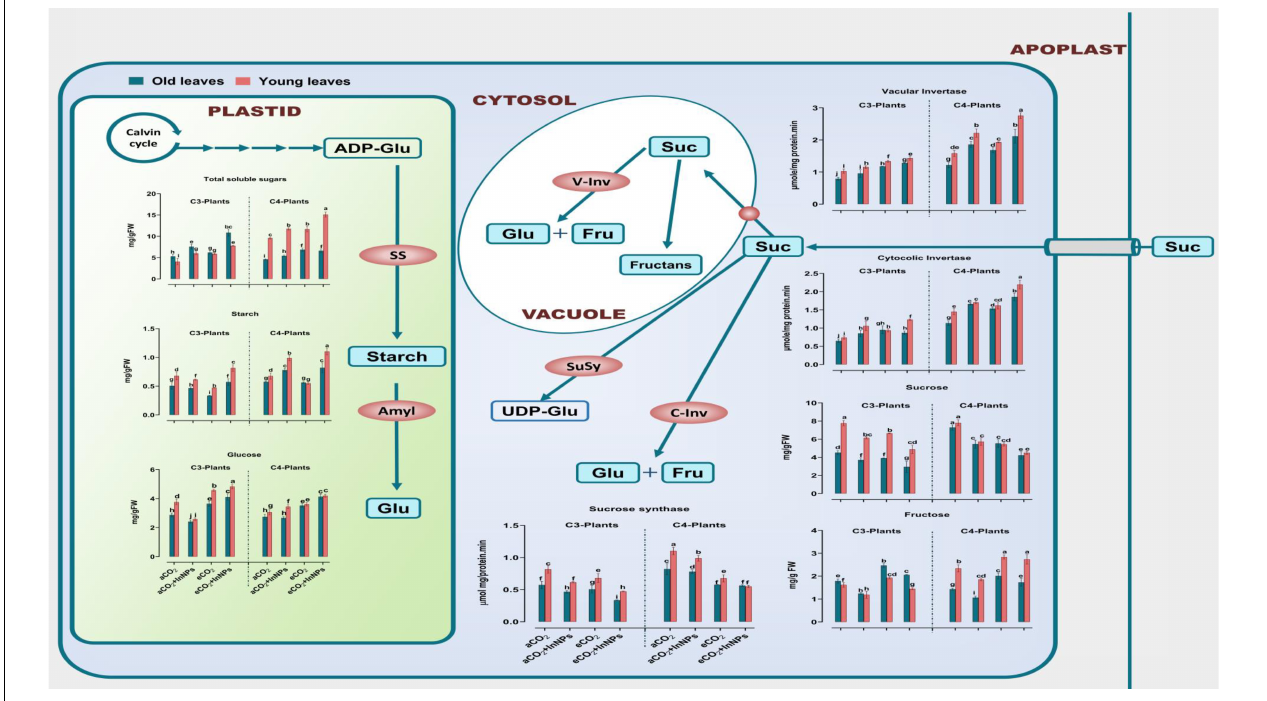
FIGURE 2 | Effect of the co-application of future climate CO 2 and In 2 O 3 -NPs upon the sugar metabolism in both old and young leaves of C3 and C4 plants. Four biological replicates are used to measure each value. The bars on the columns represent error bars (SE). One way ANOVA test ( P < 0.05; n = 4) was applied to show the significant difference between groups. Different letters showed the significant difference between